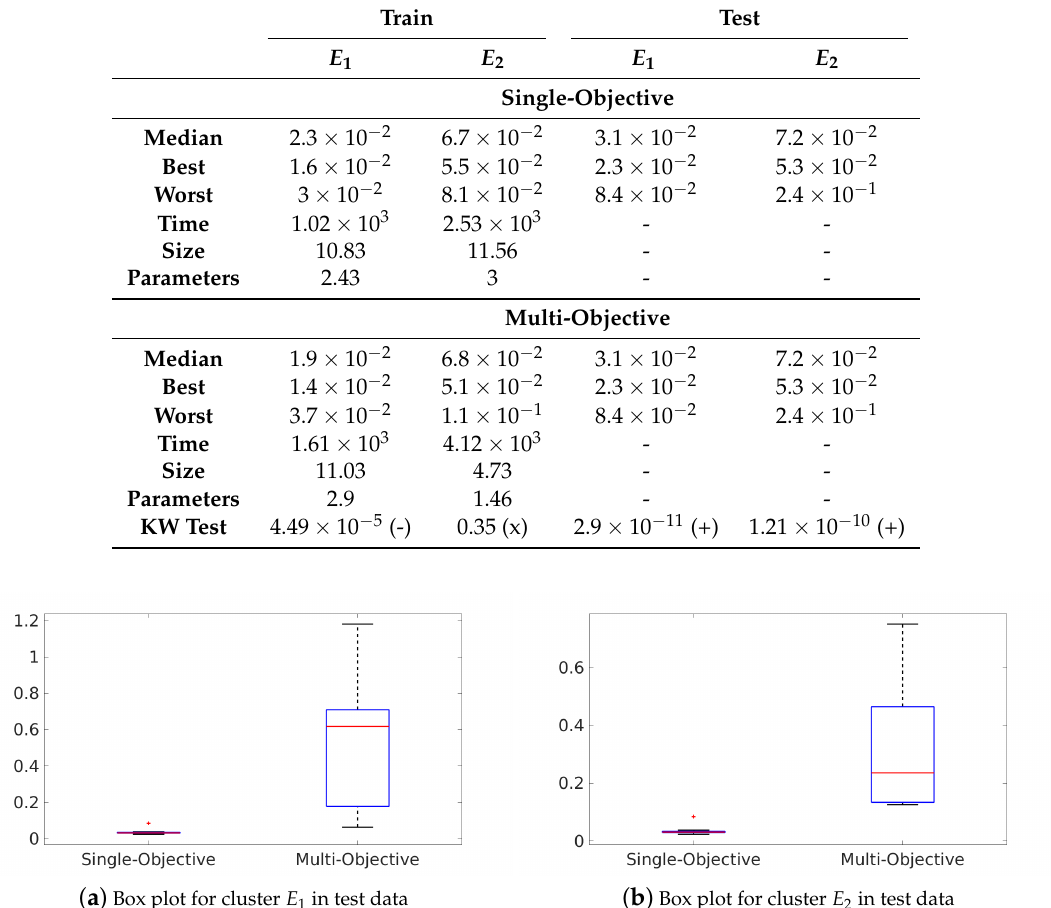
Table 3. Results for cluster of buildings E 1 and E 2 in train and test data.